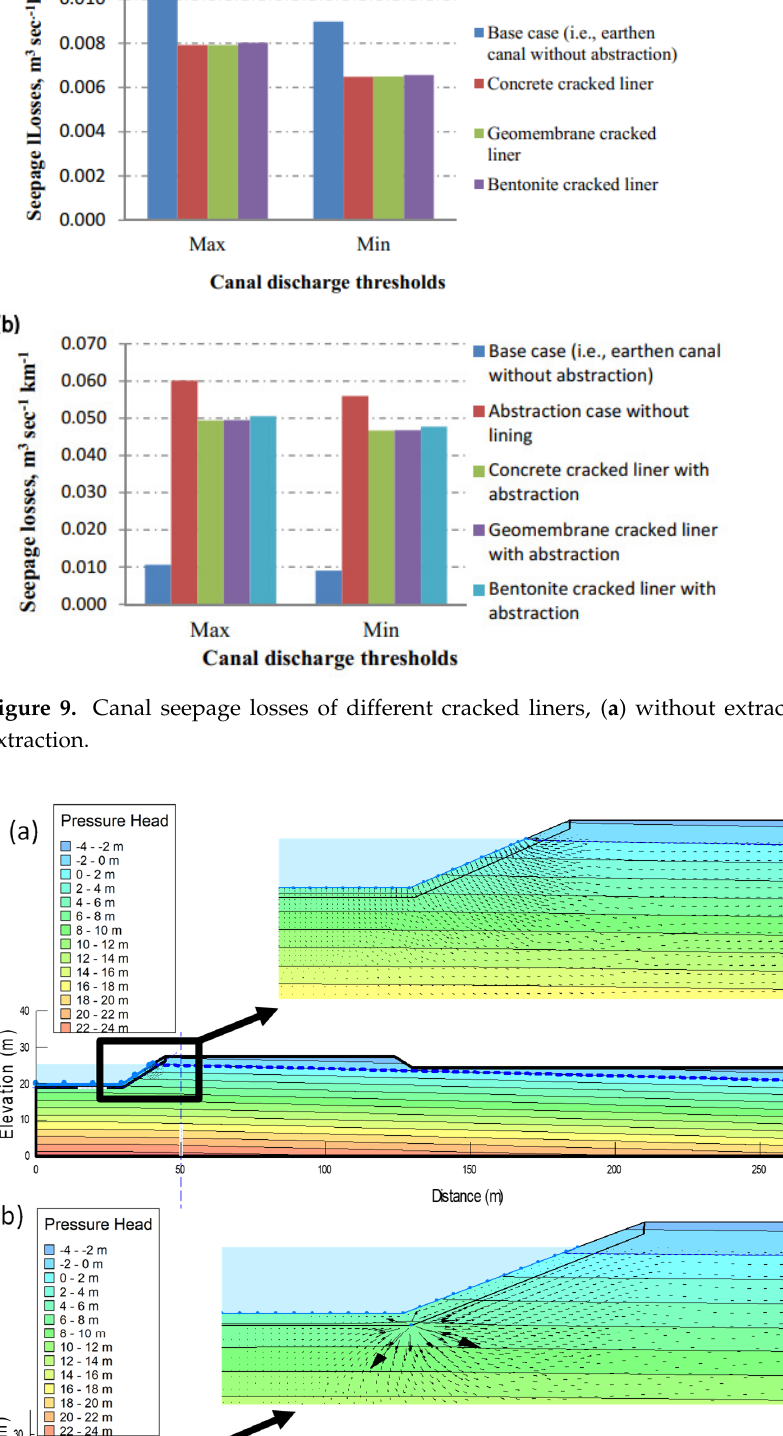
Figure 10. Seepage losses ( a ) base case (i.e., unlined canal), and ( b ) cracked